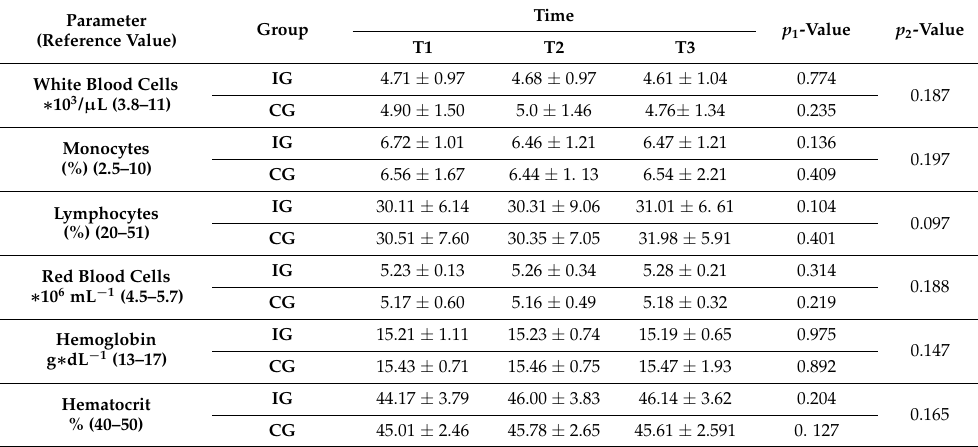
Table 3. Hematological biomarkers in the intervention group (IG n = 15) and in the control group (CG n = 15), in the three moments of the study. Parameter Group (Reference Value)